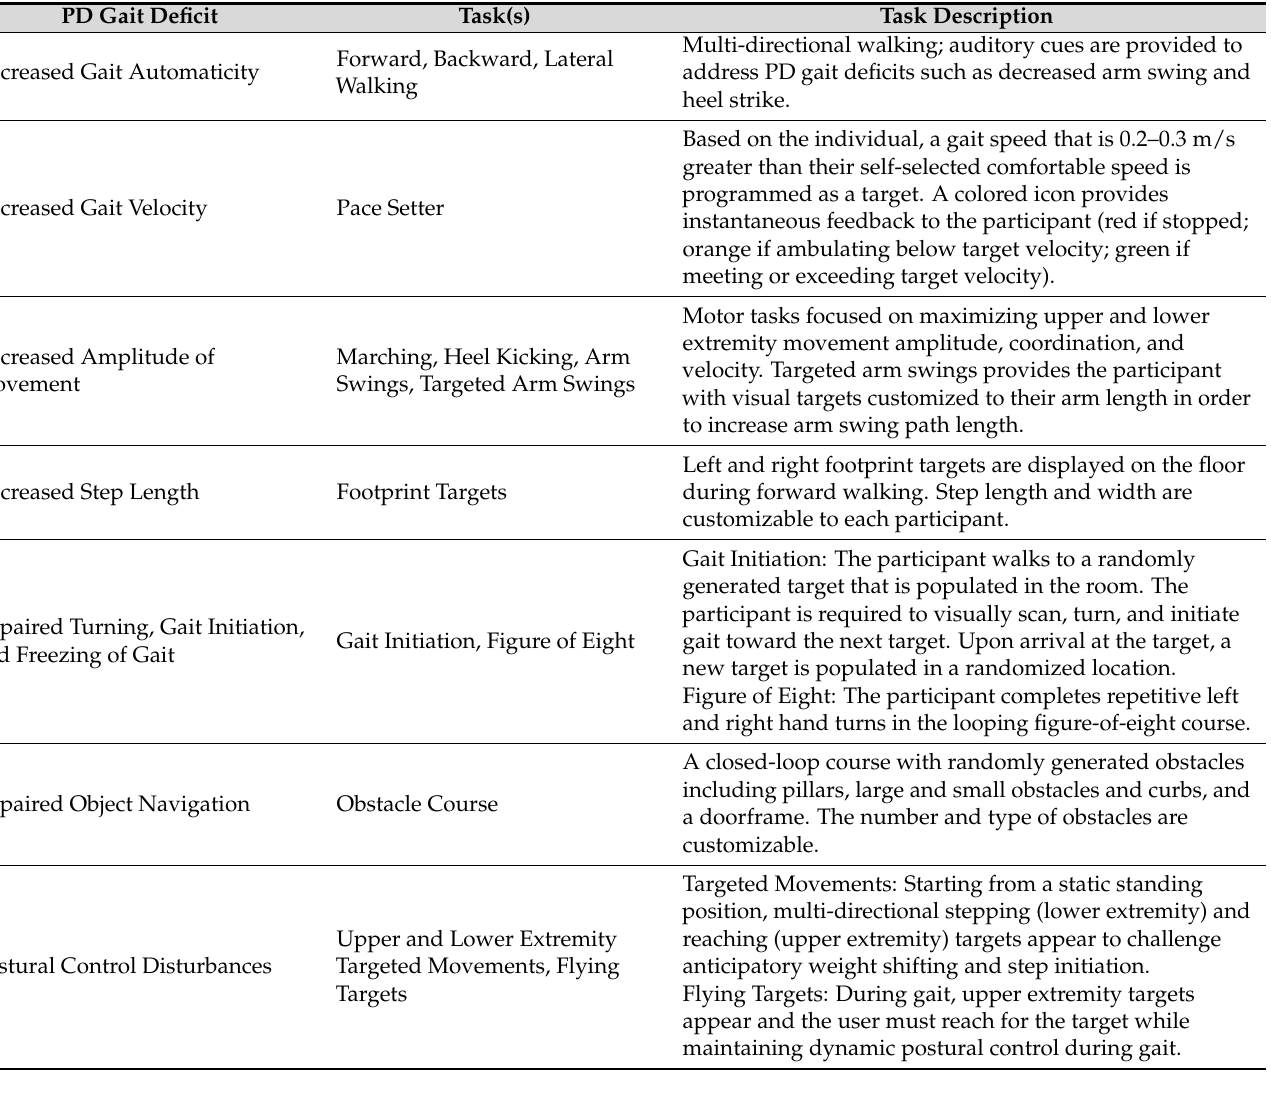
Table 1. DART motor tasks.